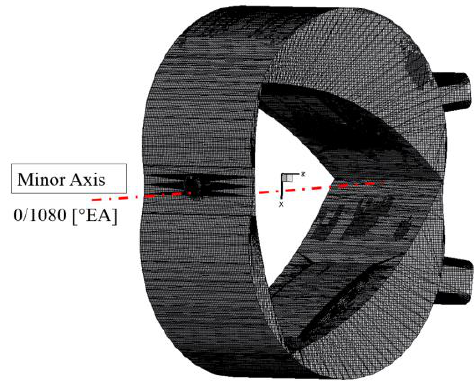
Figure 7. Meshed zones of the CFD model.